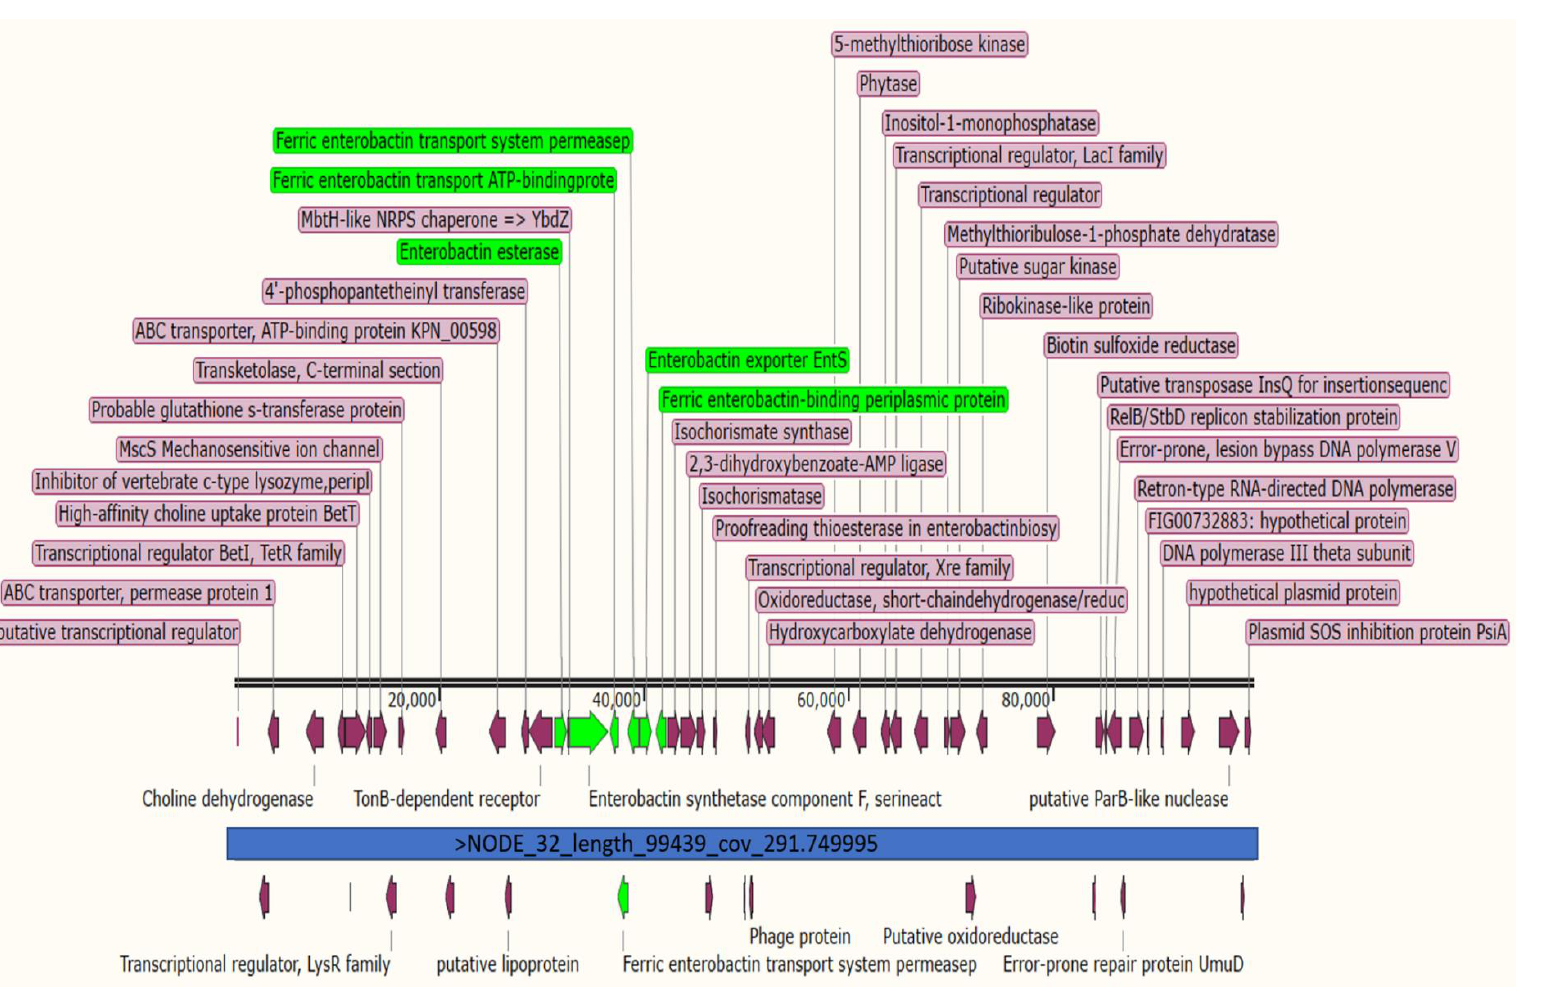
Figure 3. Clustering enterobactin proteins in contig 32 of K. pneumoniae 9KP; the horizontal black lines indicate the contig length, the green arrows indicate genes encoding enterobactin proteins, and the purple arrows indicate other genes located at the same contig.